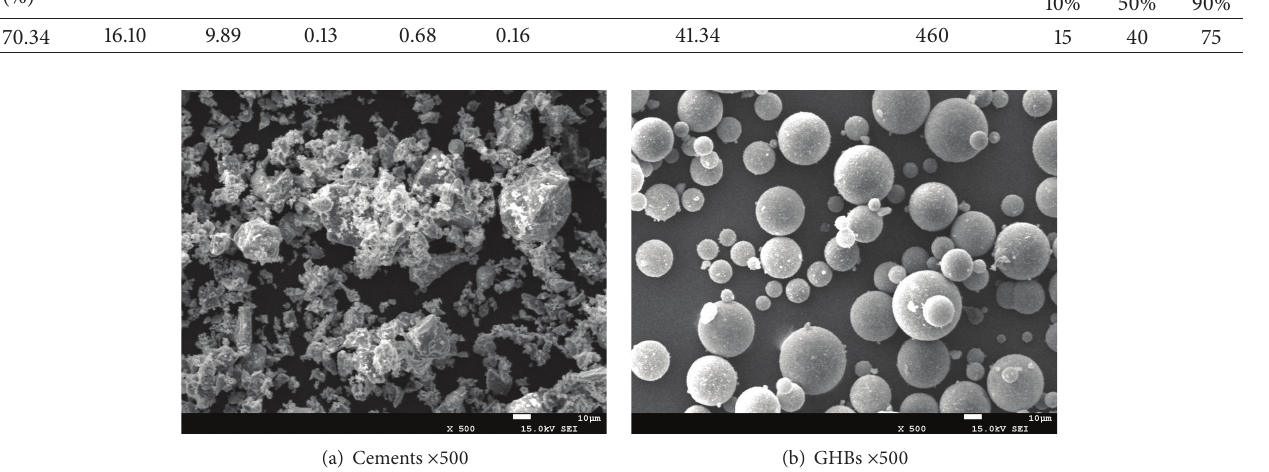
Table 1: The primary physical and chemical characters of GHBs.